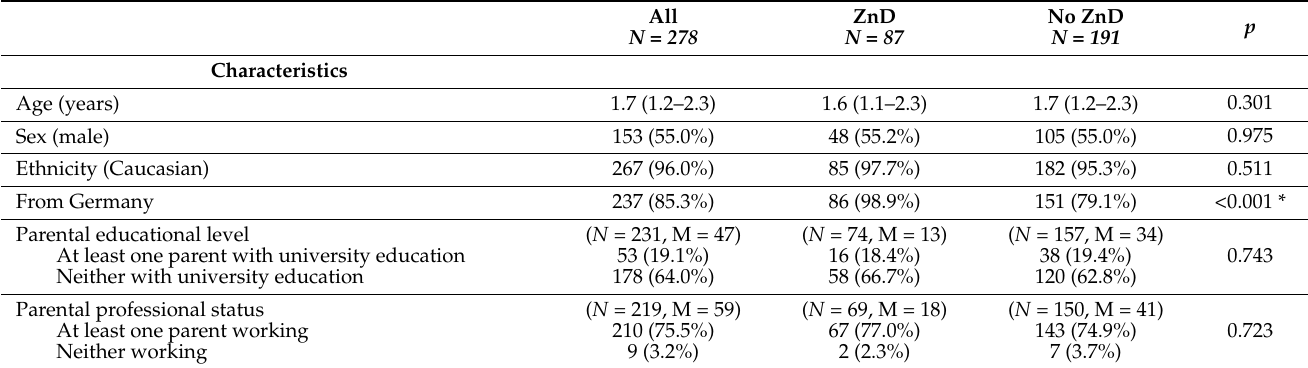
Table 1. Characteristics and dietary intake of the study population (1–3 years of age) and relation to Zn status.